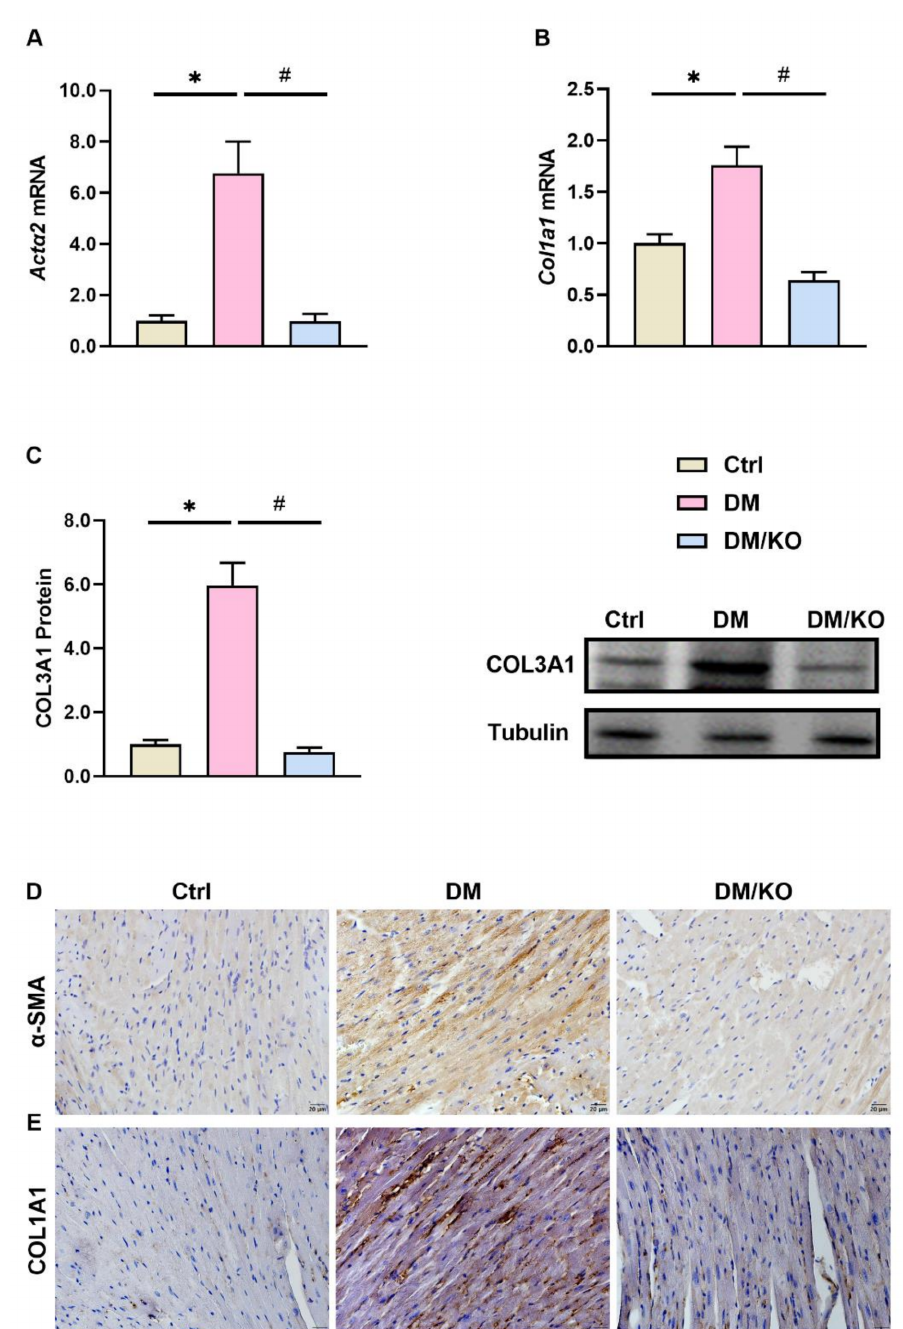
Figure 2. KO prevented the DM-induced cardiac expression of profibrotic genes. Cardiac mRNA expression of ( A ) Act α 2 and ( B ) Col1 α 1 were determined by qRT-PCR. Cardiac protein expression of ( C ) COL3A1 was determined by Western blot and ( D ) α -SMA and ( E ) COL1A1 were detected by Immunohistochemical staining (Bar = 20 µ m). Tubulin and Rplp0 (also known as 36b4 ) were used as endogenous controls for Western blot and qRT-PCR, respectively. The data were normalized to Ctrl and summarized as means ± SD. *, p < 0.05 vs. Ctrl; #, p < 0.05 vs. DM. Abbreviations: α -SMA, alpha-smooth muscle actin; Act α 2 , actin alpha 2; Col1 α 1 , collagen 1 alpha 1; COL3A1, collagen 3 alpha 1; Rplp0 , acidic ribosomal phosphoprotein P0. Other abbreviations are the same as Figure